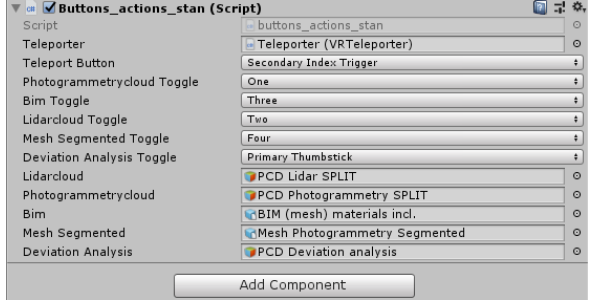
Figure 4: The ability to toggle on or off certain models benefits the workability of the game. The depicted script allows to couple the Oculus Rift controller’s buttons to a certain